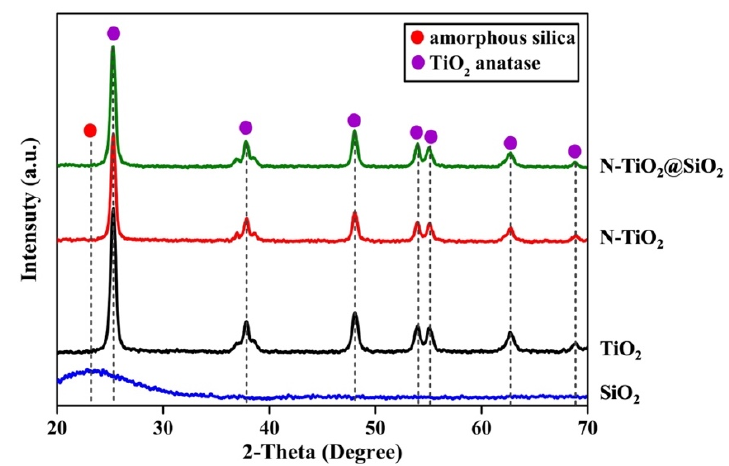
Figure 1. XRD patterns of SiO 2 , TiO 2 , N-TiO 2 , and N-TiO 2 @SiO 2 .